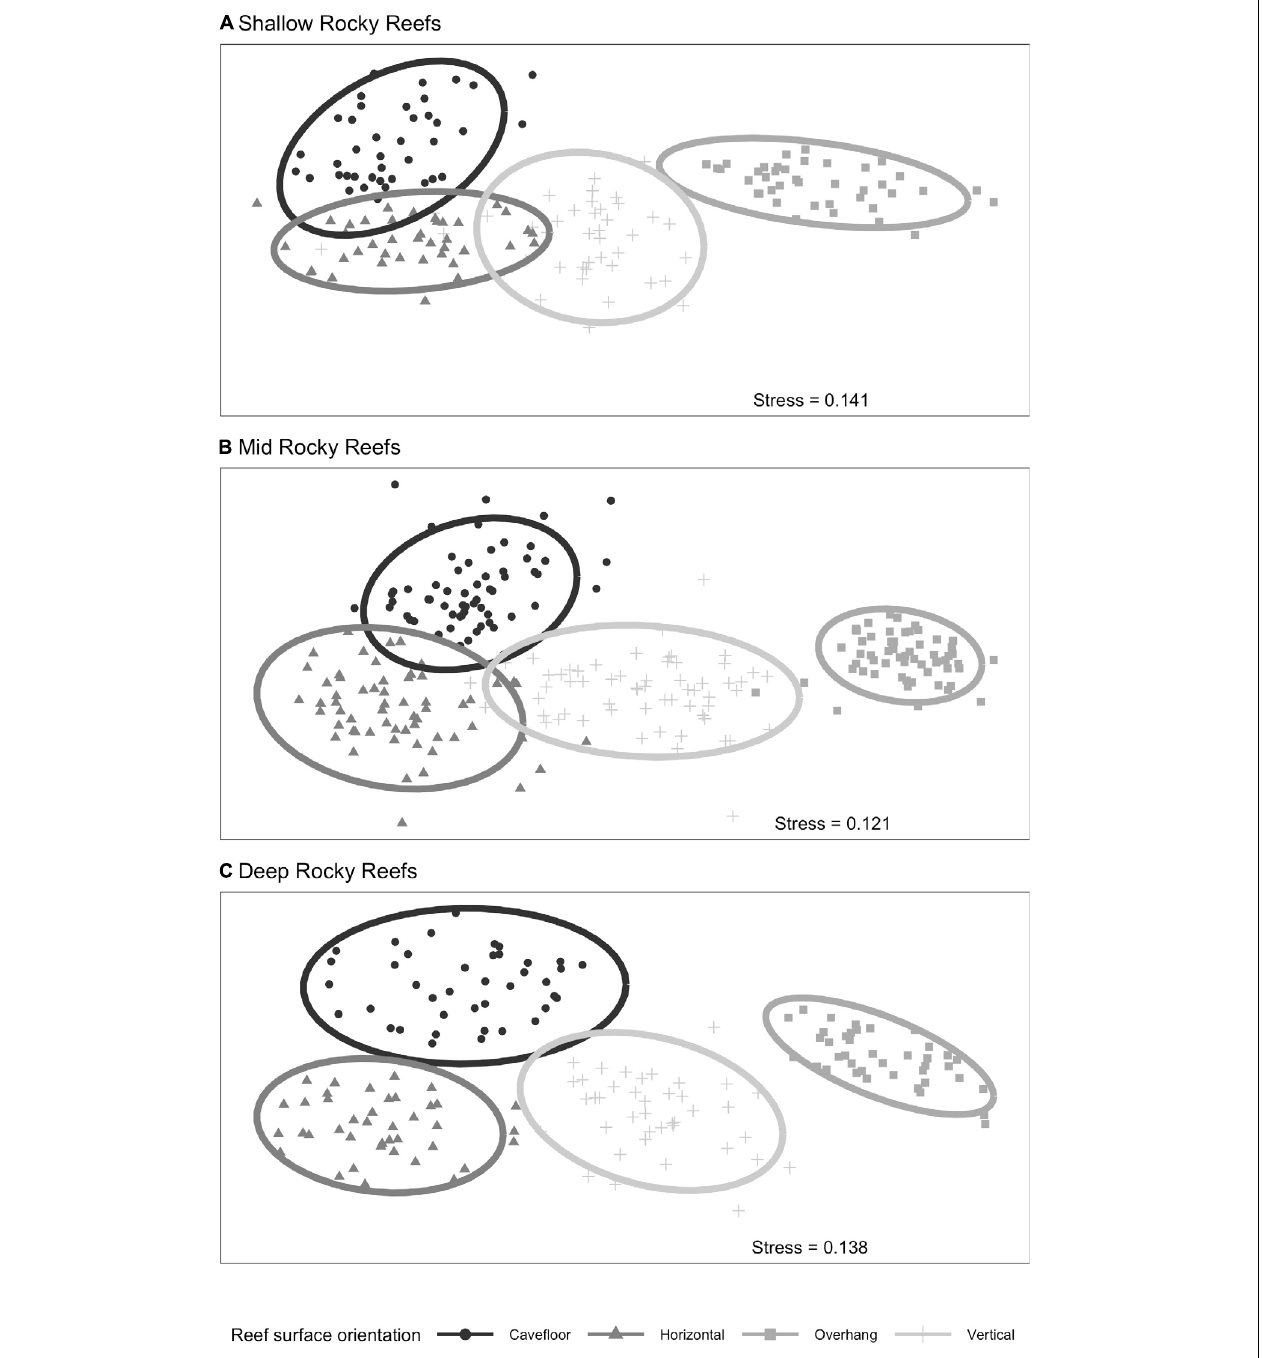
FIGURE 2 | nMDS ordination plots of rocky reef surface orientation of epibenthic assemblage by depth (A) shallow, (B) mid, and (C) deep reefs. Ellipses represent 95% confidence interval. Based on Bray-Curtis distance metric and with log (x+1) transformed data.